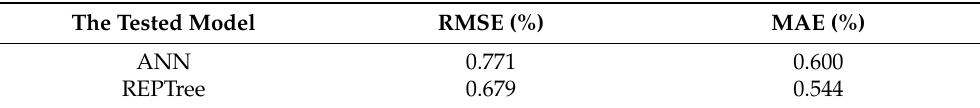
Table 4. Error statistics regarding WDEL estimation by the REPTree and ANN models using testing data